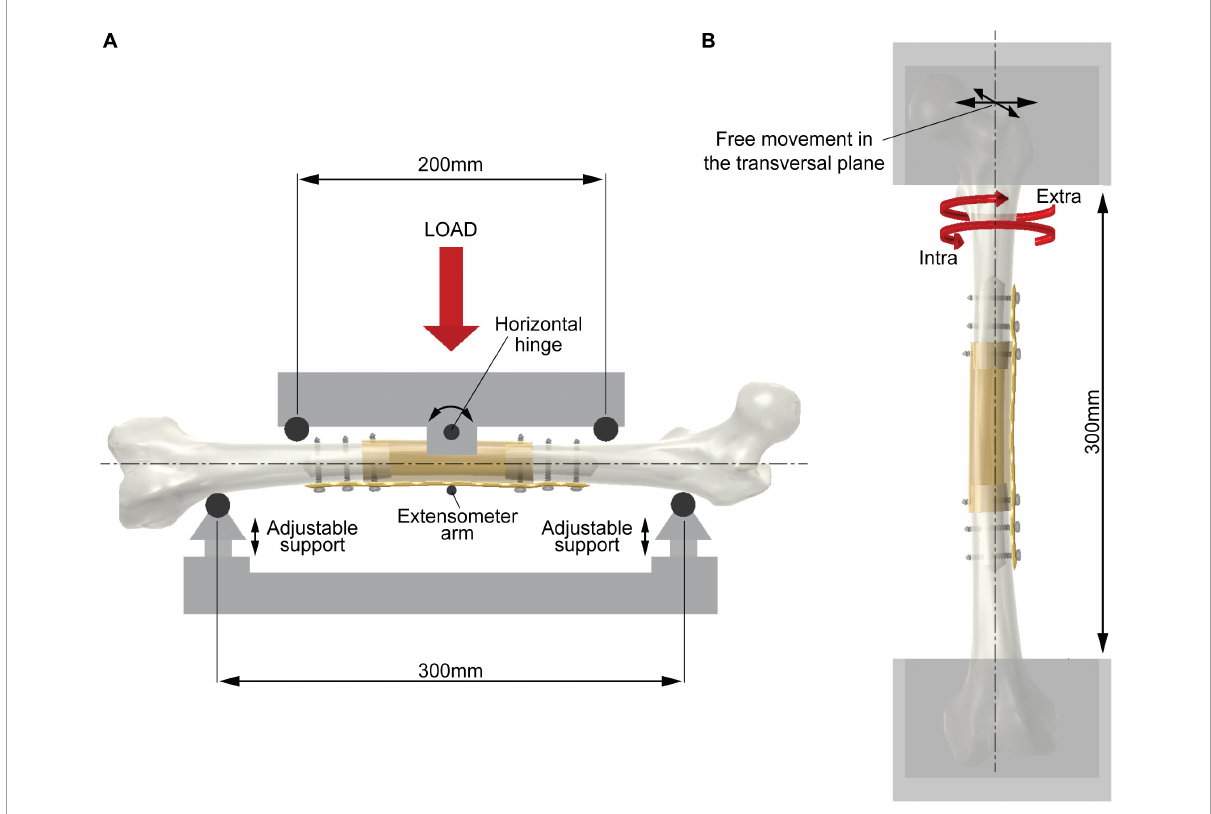
FIGURE1 Scheme of the experimental setup. (A) Four-point bending test (showing bending in the coronal plane). The two support rollers (span 300 mm) are adjustable in the vertical direction to place the femoral axis in the horizontal position. The two loading rollers (span 200 mm) rotate around a horizontal hinge to ensure equal force between the roller and diaphysis surface during testing. An extensometer measures the vertical deflection of the mid cross-section. (B) Torsion test. The femoral axis is aligned with the testing machine axis. The two epiphyses are constrained by acrylic resin in metal holders leaving a free length of 300 mm. The upper holder is free to move in the transversal plane. The biaxial testing machine avoids undesired axial load during